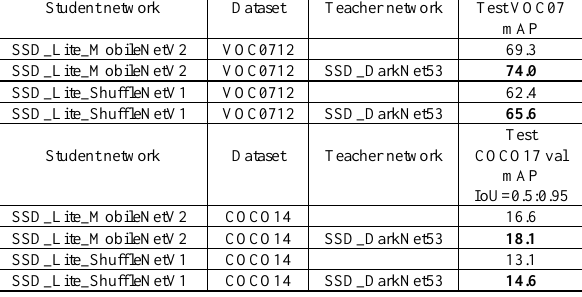
Table 4. Results on Pascal VOC and MS Coco